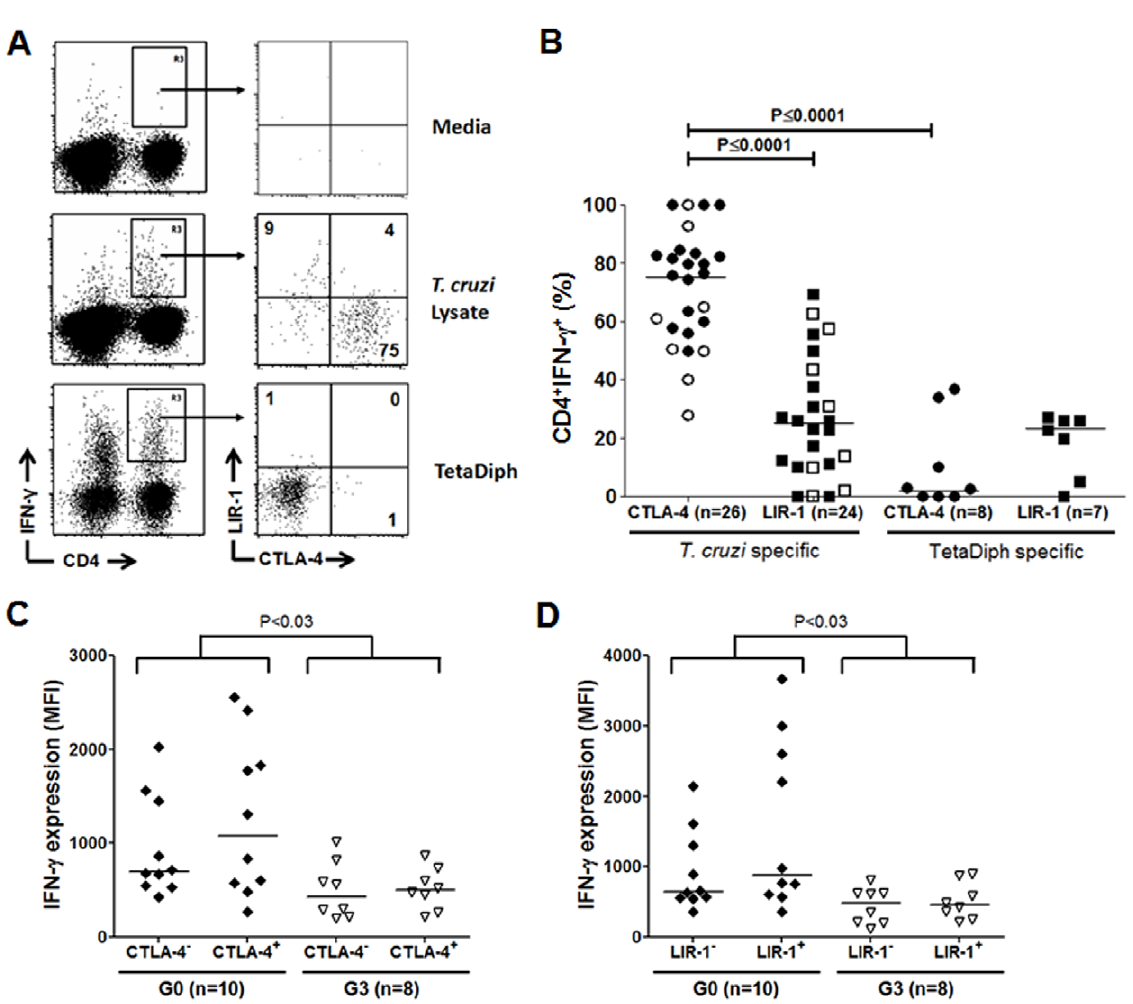
Figure 1. CTLA-4 and LIR-1 are expressed by T.cruzi antigen-responsive CD4 + T cells. PBMCs were stimulated for 18 hours in the presence of an amastigote T. cruzi lysate (middle panel), a mix of tetanus/diphtheria toxoids (low panel) or media alone (top panel). Cells were stained with anti-CD4 and anti-LIR-1 monoclonal antibodies followed by fixation and permeabilization for the intracellular staining with anti-IFN- c and anti-CTLA-4 monoclonal antibodies. (A) Representative dot plot from a G0 T. cruzi -infected subject. Lymphocytes were gated by forward and side light scatter and subsequently analyzed by IFN- c vs. CD4. The right graphs show CTLA-4 and LIR-1 staining of R3 gated cells. The figures indicate the percentage of CD4 + IFN- c + CTLA-4 + (lower right quadrant), CD4 + IFN- c + LIR-1 + (upper left quadrant), and double CD4 + IFN- c + CTLA-4 + LIR-1 + T cells (upper right quadrant). (B) Frequencies of CTLA-4 + and LIR-1 + T cells in the CD4 + IFN- c + T cell compartment from 18 chronically infected subjects without cardiac symptoms (closed symbols, n=10) or with severe cardiomyopathy (open symbols, n=8). Median values are indicated by the horizontal lines. (C) MFI of IFN- c on CTLA-4 + and CTLA-4 2 CD4 + T cells specific for T. cruzi in asymptomatic and symptomatic T. cruzi -infected subjects. (D) MFI of IFN- c on LIR- 1 + and LIR-1 2 CD4 + T cells specific for T. cruzi in asymptomatic and symptomatic T. cruzi -infected